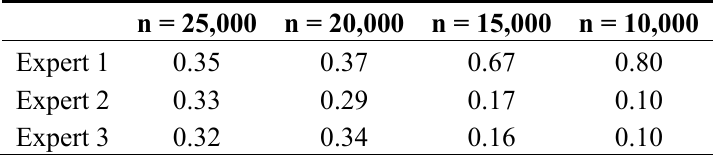
Table 2. Estimated weights for each expert using different training sizes, n is the number of adjoin clock cycles selected for training.